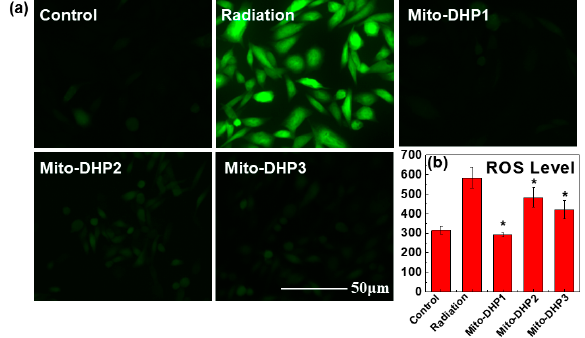
Figure 2. ROS detection using the DCFH-DA agent. ( a ) Fluorescence images of CHO-K1 cells from different groups following incubation with DCFH-DA for 30 min; ( b ) ROS level in Mito-DHPs treated and untreated cells at 24 h after 3 Gy radiation. (* p < 0.05 compared with radiation group).